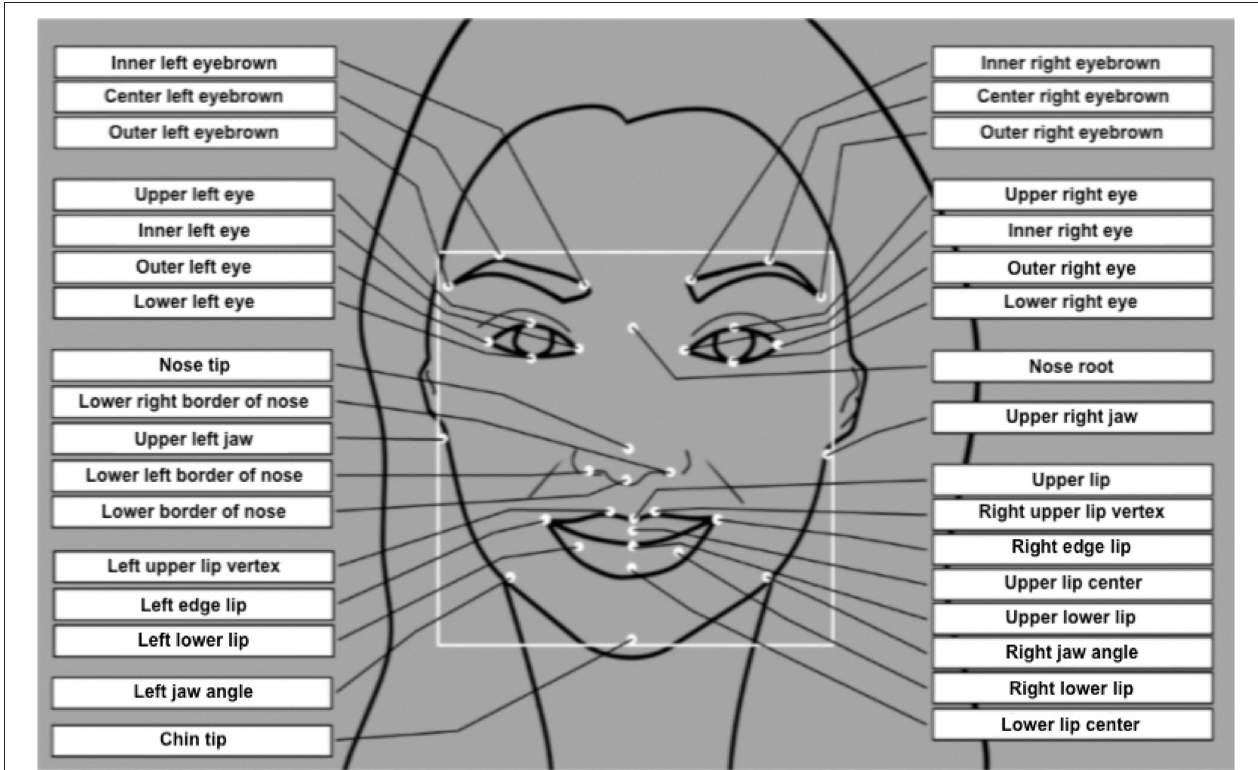
FIGURE 1 | The different movements of human facial muscles as predictors of emotions based on the Facial Expressions Analysis (FEA) and Facial Action Coding System (FACS).